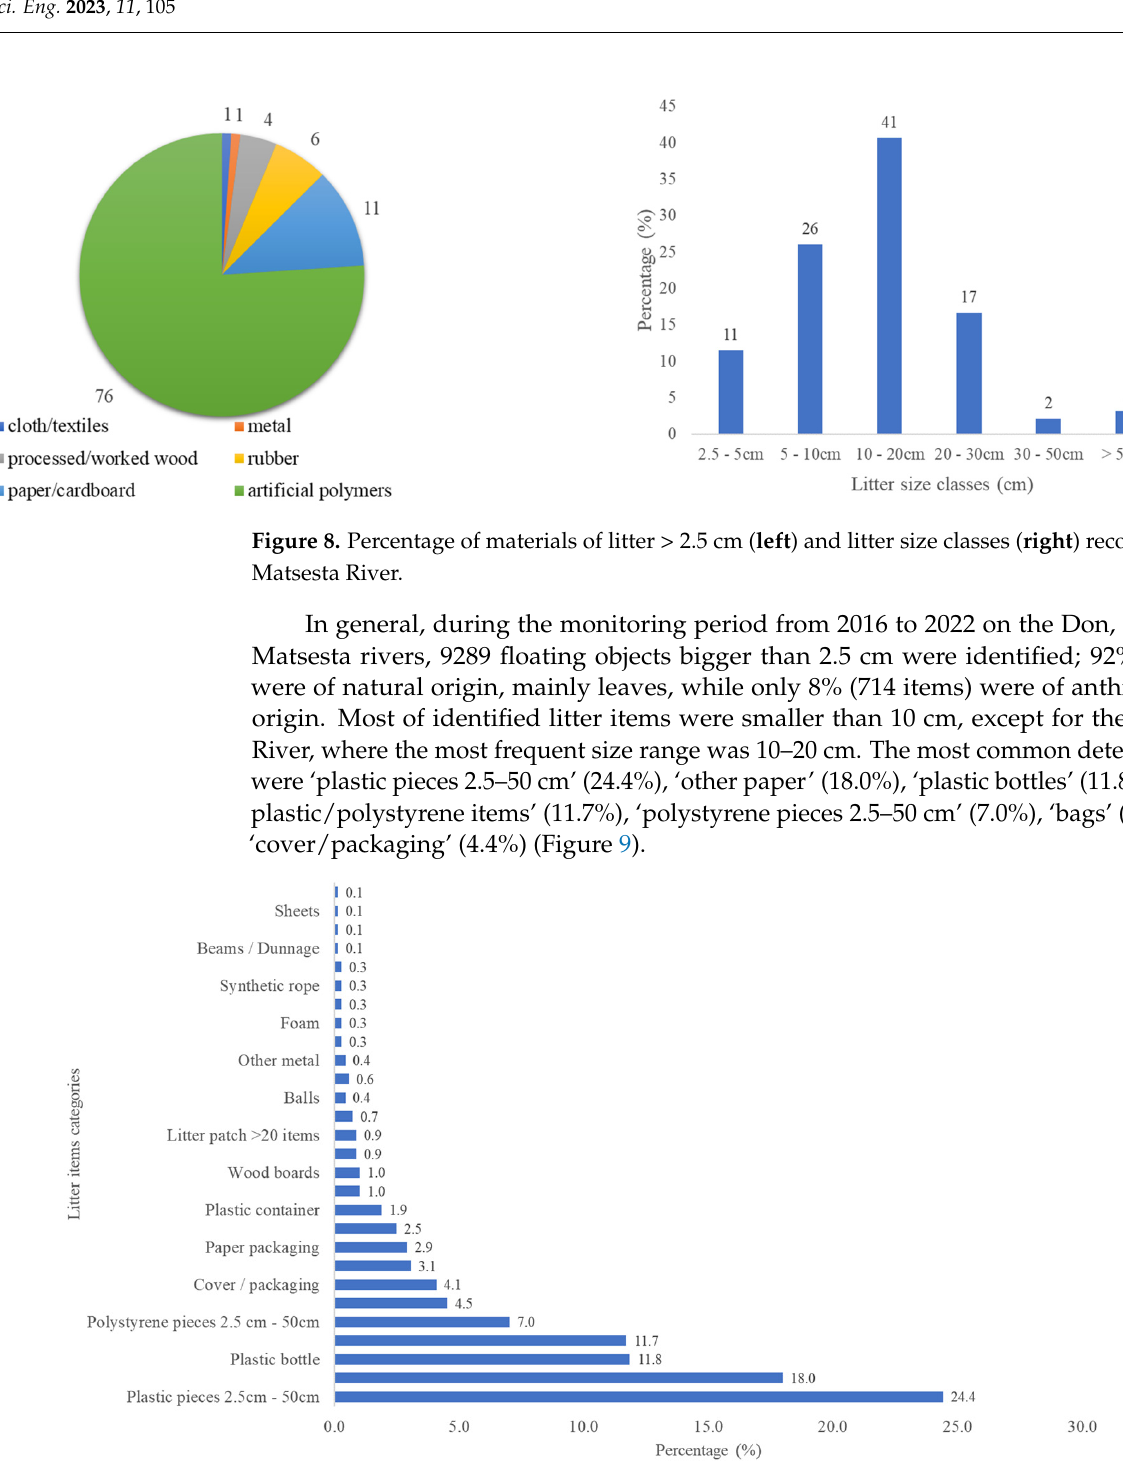
Figure 7. Percentage of recorded litter item categories at the Matsesta River.